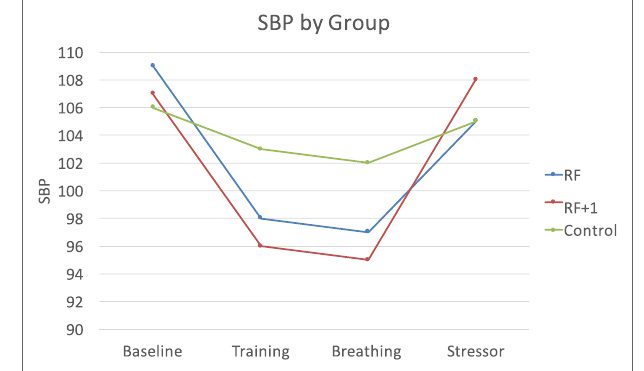
FigUre 1 | The RF group showed the largest LF/HF response to the breathing practice, with the RF + 1 showing minimal LF/HF changes and the control group decreasing during this time